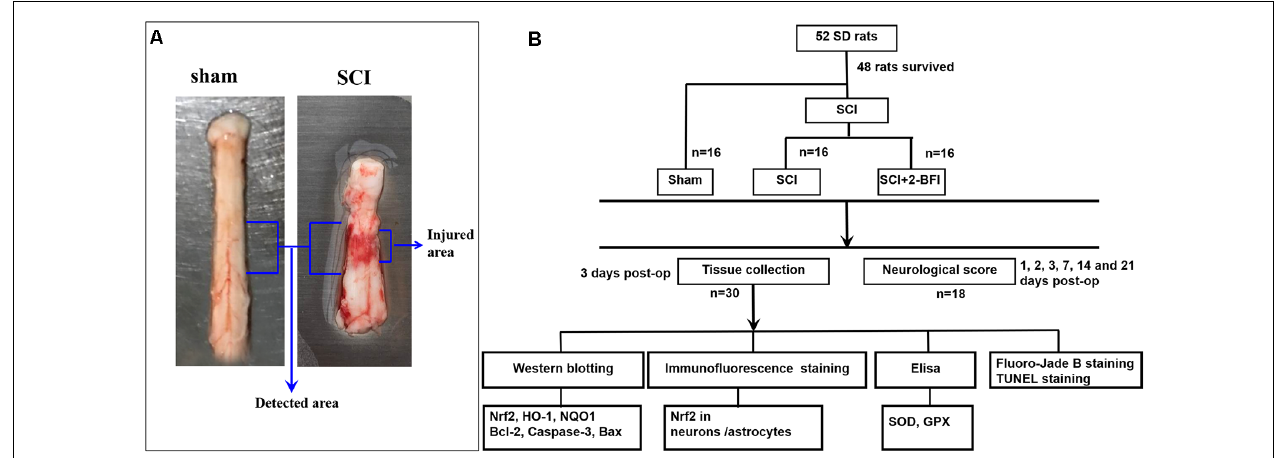
FIGURE 1 | Spinal cord tissue surrounding the damaged site was immediately collected after the animals were deeply anesthetized (A) . Experimental design: experiments were designed to show the potential neuroprotective effects of 2-BFI in spinal cord injury (SCI; B